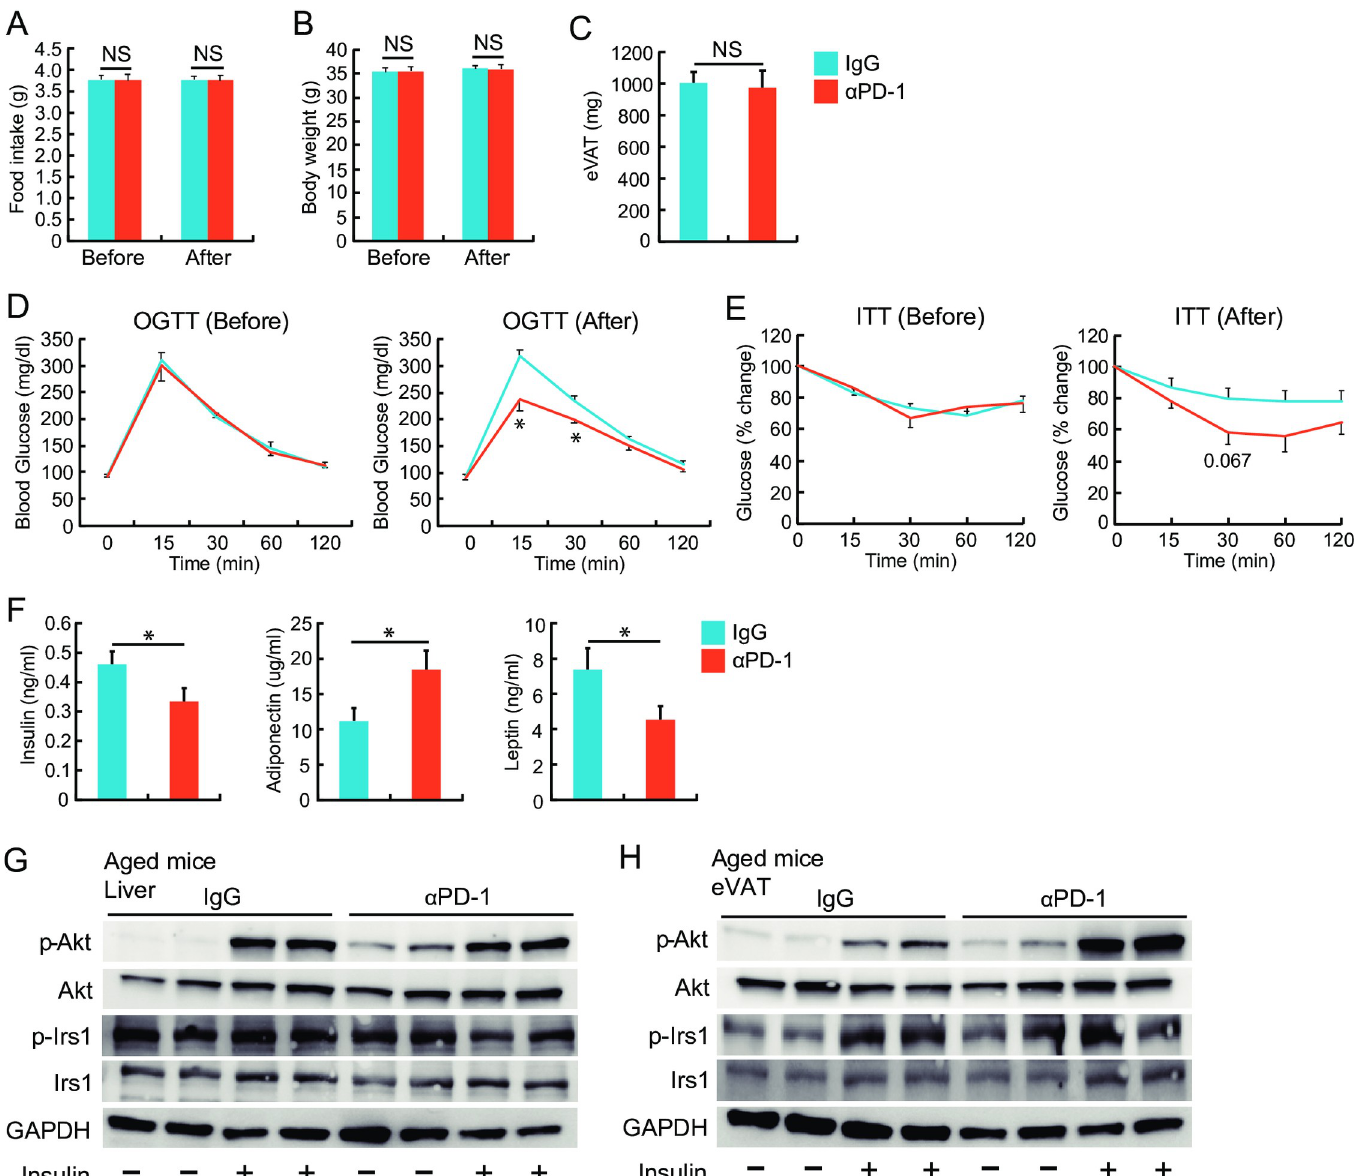
Fig 6. Effects of anti-PD-1 antibody treatment on insulin resistance in aged mice. Either anti-mouse PD-1 antibody ( α PD-1) or control IgG (IgG) was administered three times per week for three weeks to 77-week-old mice. All examinations were performed when mice reached 80 weeks of age ( n = 6–8 mice in each group). ( A ) Daily food intake and ( B ) body weight (BW) were compared between IgG-treated and α PD-1-treated aged mice before and after treatment. ( C ) eVAT weight was compared between aged mice treated with either α PD-1 or IgG. ( D , E ) Results of the OGTT and ITT between IgG-treated and α PD-1-treated aged mice before and after treatment, respectively. ( F ) Serum levels of insulin, adiponectin, and leptin in aged mice treated with α PD-1 or IgG. Representative Western blot images showing total and phosphorylated Akt/PKB at the serine 473 residue, total and phosphorylated insulin receptor substrate (IRS) 1 at the serine 307 residue, and GAPDH expression levels, at baseline and after insulin administration in the liver ( G ) and eVAT ( H ) obtained from aged mice treated with either IgG or α PD-1. � P < 0.05; NS: not significant. Data are represented as the mean ± SEM.